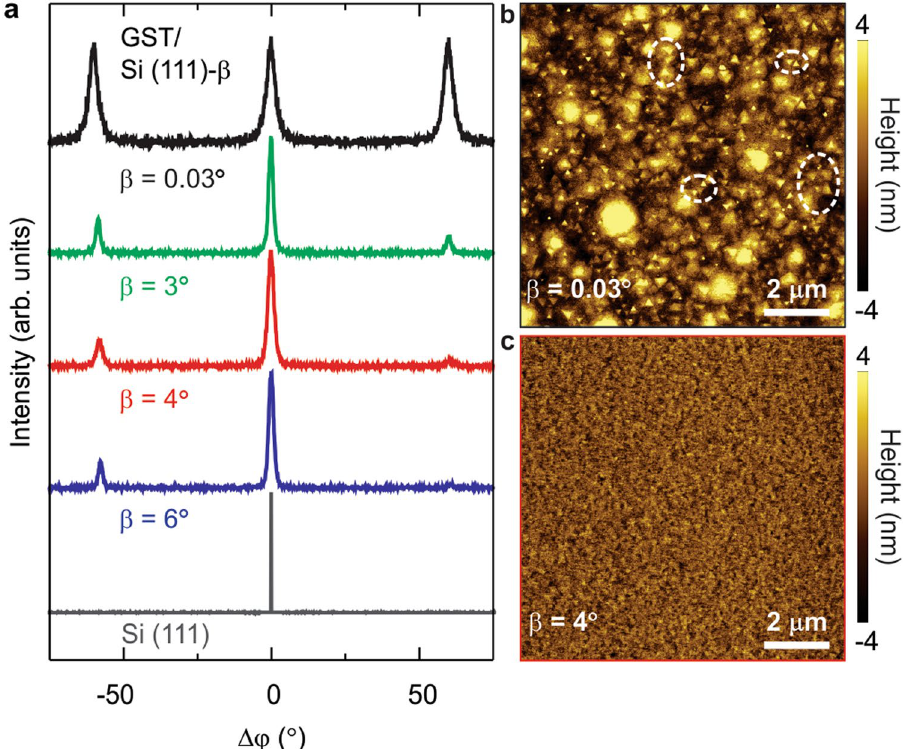
Figure 3. Suppression of GST twin domains by the effect of the Si step edges. ( a ) Φ scans around GST (01.13) grown on Si (111) with β = 0.03° (black), 3° (green), 4° (red), 6° (blue). The twinnings are nearly suppressed for β = 3–6°. ( b , c ) AFM topography (10 × 10 µ m) for the samples with β = 0.03 and 4°,